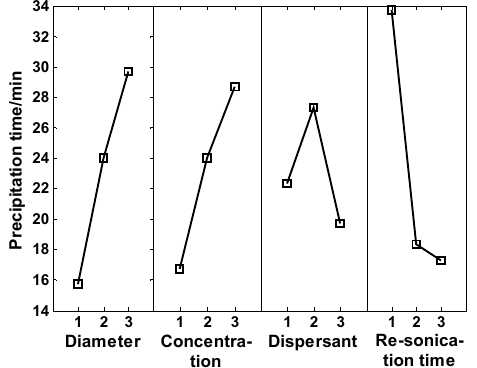
Figure 10. E ff ects of four key Figure 10. Effects of four key factors.